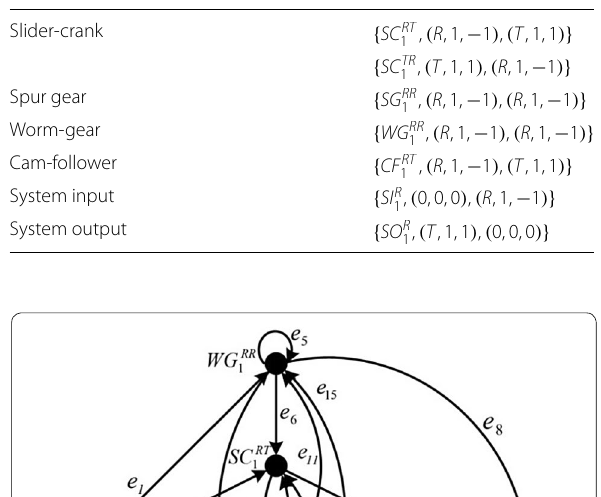
Table 4 Seven KFUs of the design example Mechanisms